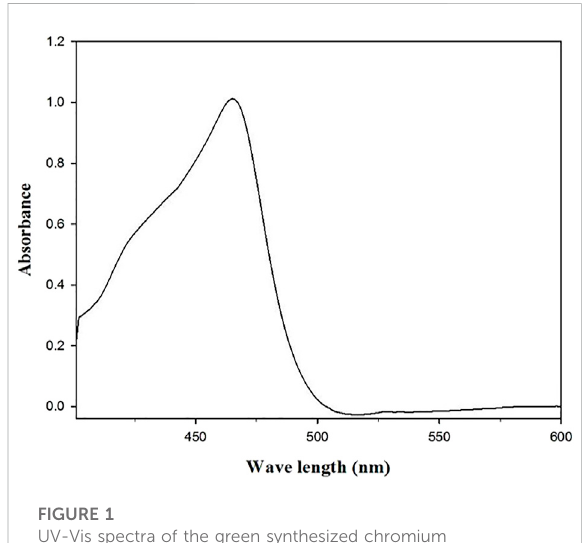
FIGURE 1 UV-Vis spectra of the green synthesized chromium nanoparticles.